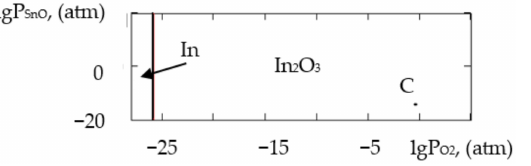
Figure 7. PPD in In–Sn–O system at temperature T = 873 K within lgP O2 –lgP SnO